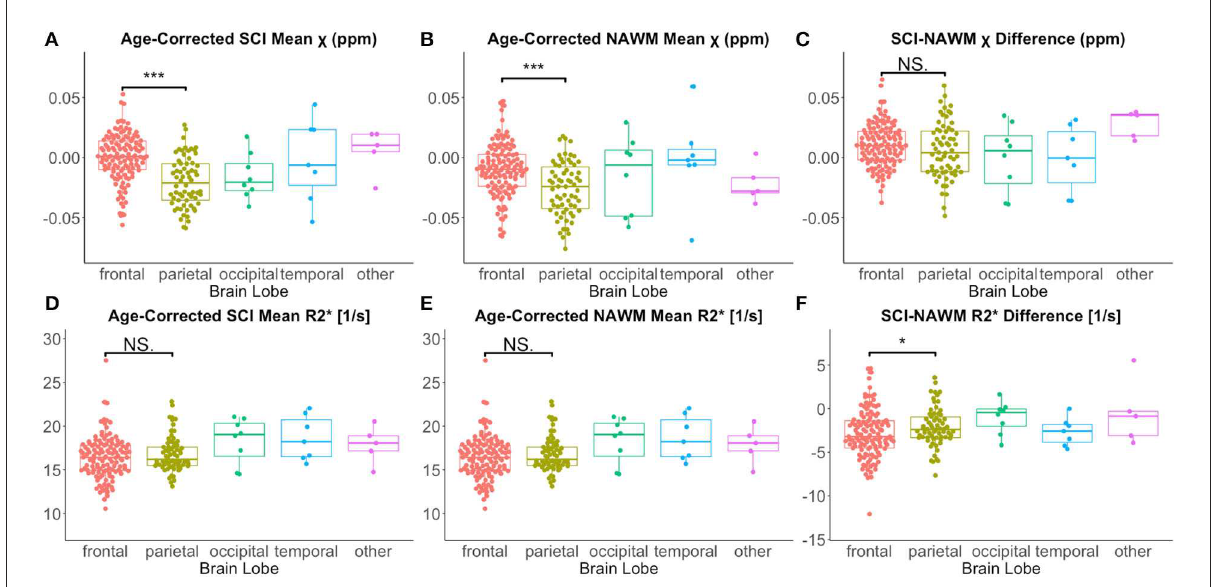
FIGURE7 Effect of anatomical location on SCI and NAWM χ and R * 2 . Comparison of mean susceptibility ( χ ) and R * 2 measured in silent cerebral infarcts (SCI) in each of the brain lobes. (A) SCI in the frontal lobe were significantly more paramagnetic relative to lesions in the parietal lobe. (B) This lobar χ difference was also observed in normal appearing white matter (NAWM). (C) This resulted in no significant differences in the SCI–NAWM susceptibility difference between the lobes. (D,E) No significant differences were observed between lobes in the SCI and NAWM mean R2*